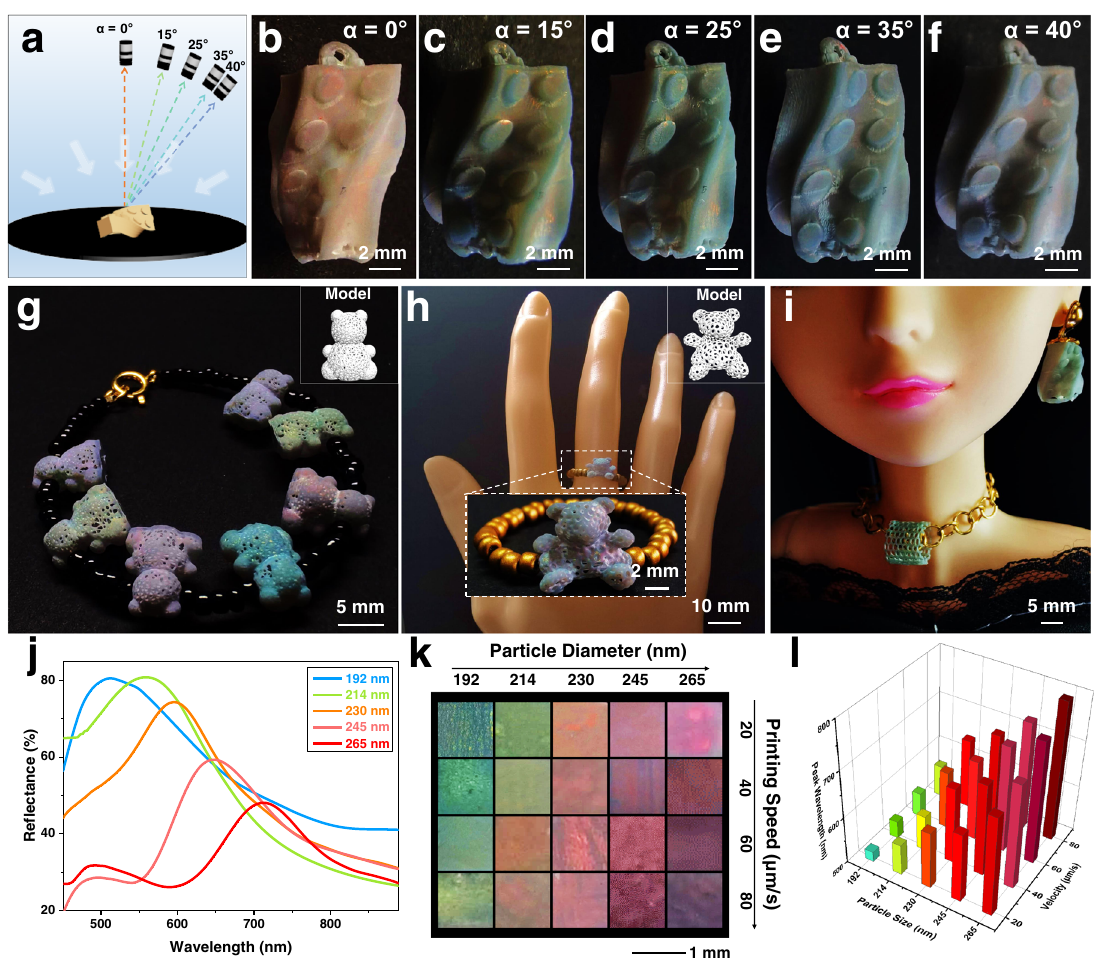
Fig. 3 | Structural color regulation. a Scheme of structural color observation of Lego brick structure from the different viewing angles ( α ) under diffusive lighting condition. b – f Optical images of the Lego brick structure with viewing angles ( α ) from0°( b )to15°( c ),25°( d ),35°( e ),and 40°( f )underdiffusivelightingcondition. The Lego brick structure is printed with PS particle diameter of 230nm. g Optical image of the customized bracelet structure composed of 3D printed bear struc- tures of different structural colors and black plastic beads. The bears from the left to right are printed with PS particle diameters of 265nm, 214nm, 245nm, 192nm, 230nm, 214nm, and 265nm, respectively. The inset of the solid white box on the upper right is the 3D bear model . h Optical image of a hand model wearing the customized ring structure, which is fabricated by connecting the 3D printed bear structure with golden plastic beads. The insets of the white dotted box in the